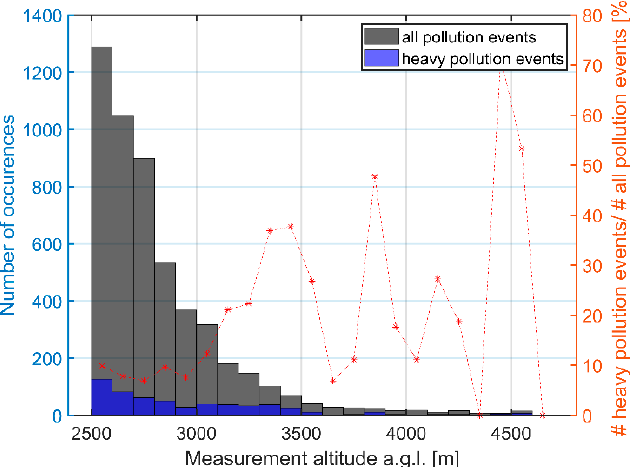
Figure 5. Histogram of the measurement altitude. The right axis shows the percentage of the heavy pollution events with regard to the total number of events for each bin size. The histogram for the total number of altitudes (black) decreases exponentially to- wards higher altitudes while the number of heavy polluted events (outside the